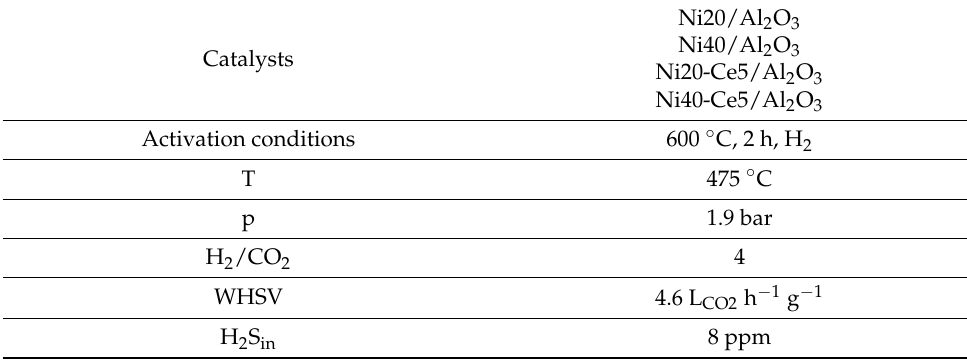
Table 14. Catalysts and reaction conditions for experiments on H 2 S influence on methanation with Ni/Al 2 O 3 and Ce promoter